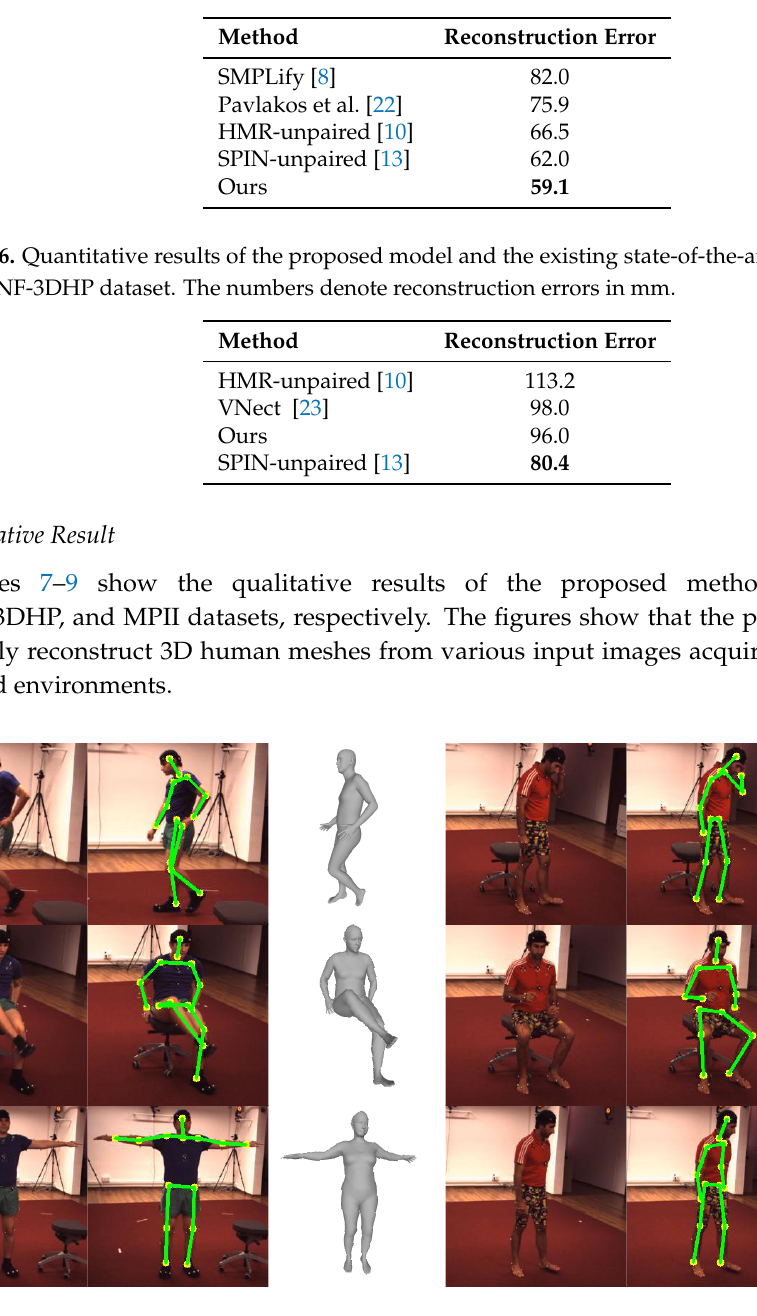
Figure 7. Qualitative results on the Human3.6M